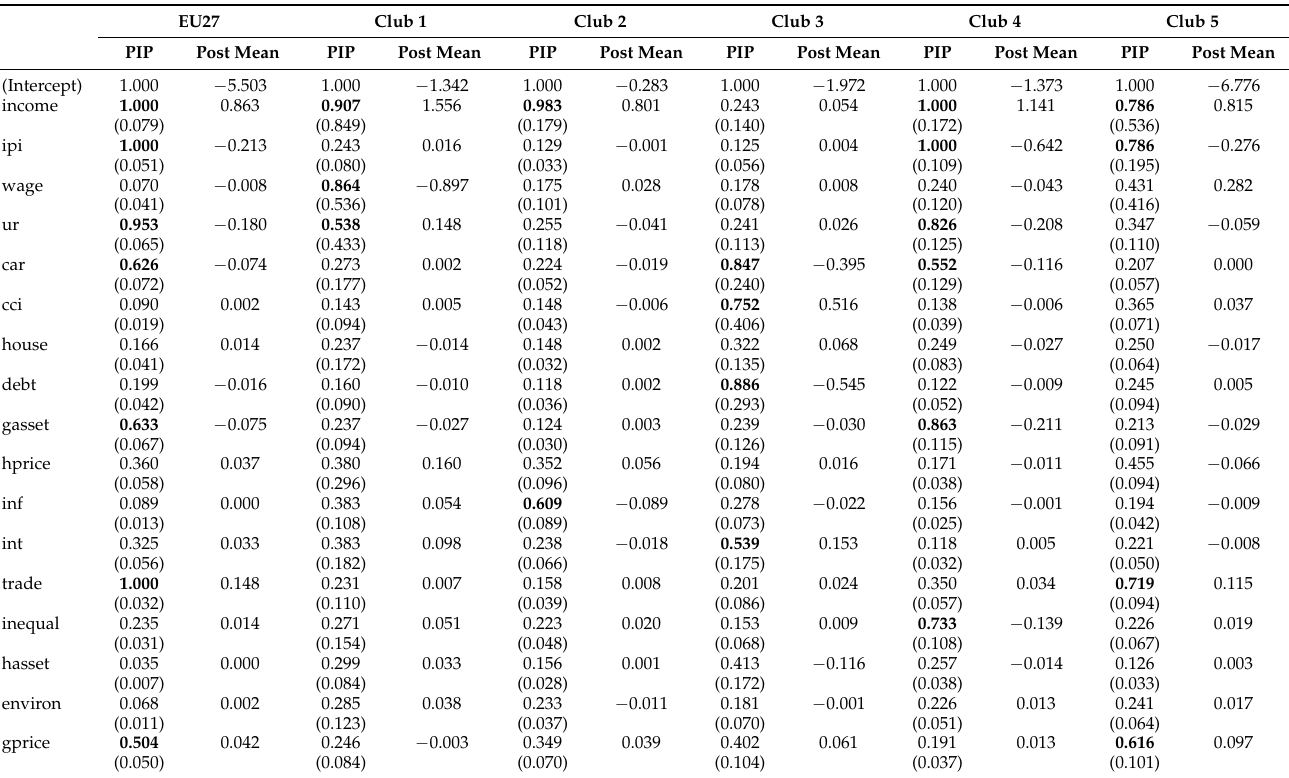
Table 3. BMA results—long-run